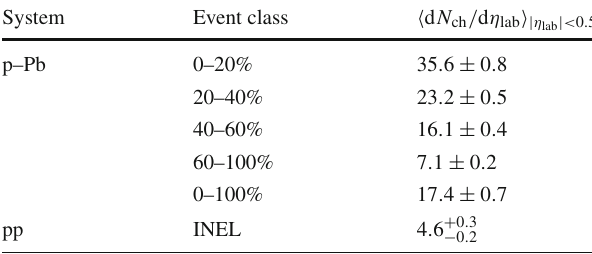
Table 1 Average charged-particle multiplicity density measured at midrapidity in the used event multiplicity intervals in p–Pb collisions at